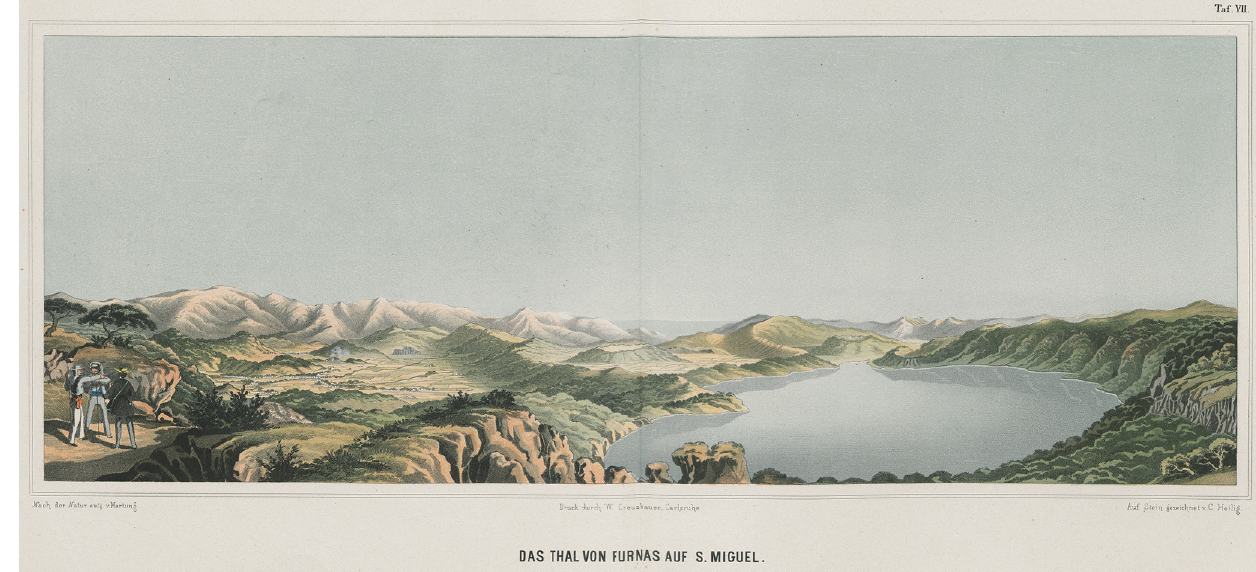
Figure 5. Hartung (1860a), plate VII, depicting a panoramic view of Furnas in São Miguel Island. The image is public domain and was digitalized by ETH-Bibliothek Zurich (https://www.e-rara.ch/zut/content/zoom/7111419, last access: 26 September 2021).